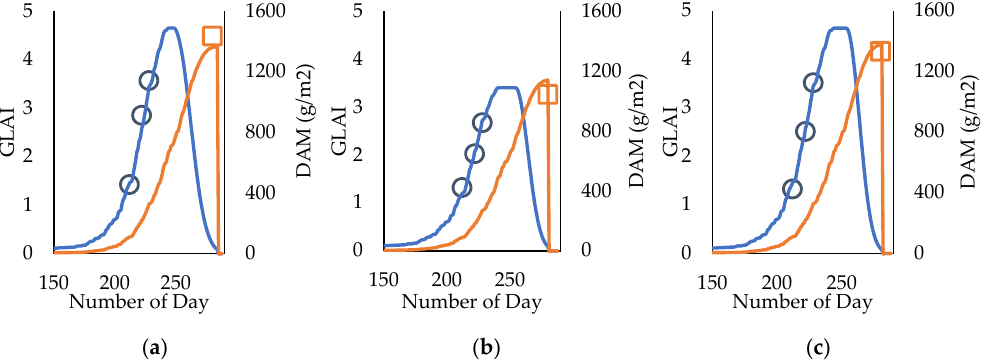
Figure 10. Seasonal variation of simulated SAFY-LAI, simulated DAM, and converted UAV derived LAIe, and ground final DAM in S2. ( a ) sampling point 8; ( b ) sampling point 16; ( c ) sampling point 26. The blue line is the daily simulate GLAI; the orange line is the daily simulate DAM; The blue circles are the converted UAV LAIe value; and the orange square is the In-situ measured DAM.